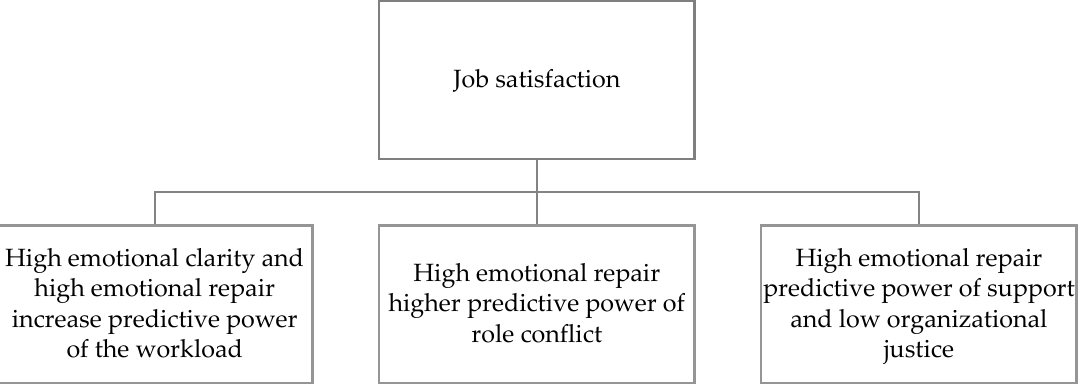
Figure 2. Moderation of emotional intelligence on the e ff ect of psychosocial risks on job